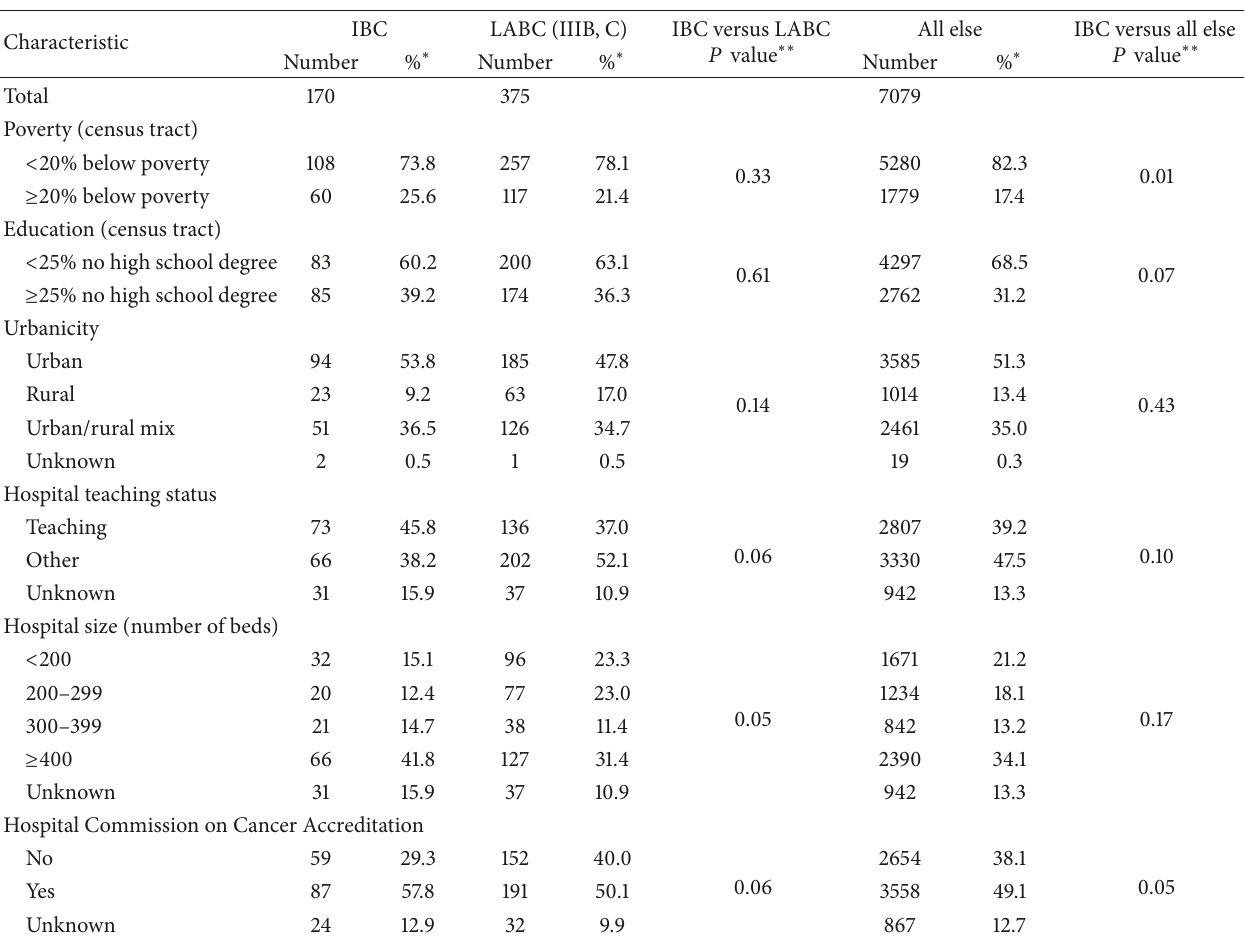
∗ Percentages weighted based on sampling design. ∗∗ 𝑃 values from chi-square